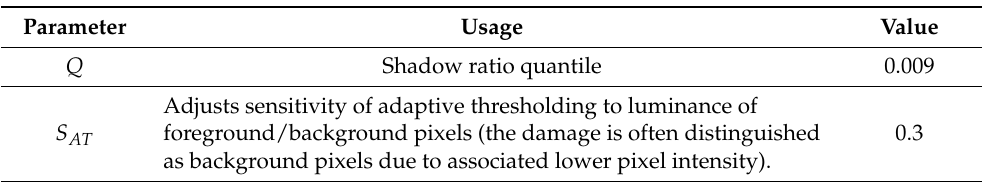
Table 2. Final optimized image thresholding parameters for the PTS damage proposal module (optimized by minimizing MSE—see Equation (1)). Parameter Usage Value Q Shadow ratio quantile 0.009 Adjusts sensitivity of adaptive thresholding to luminance of S AT foreground/background pixels (the damage is often distinguished as background pixels due to associated lower pixel